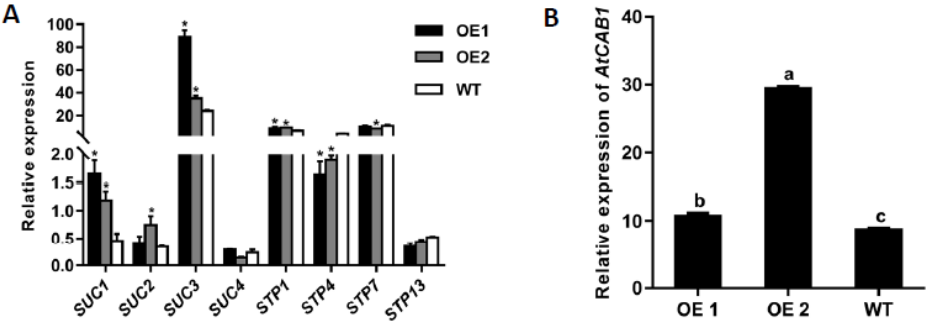
Figure 6. Effect of overexpressing CmTST1 on the plasma membrane-located sugar transporter expression. ( A ) qRT-PCR detected the expression of Arabidopsis sucrose transporter genes ( SUC1 , SUC2 , SUC3 , and SUC4 ) and sugar transporter genes ( STP1 , STP4 , STP7 , and STP13 ) in the roots of the CmTST1 OE Arabidopsis lines growing under the standard MS medium condition with 3% sucrose ( w / v ) as the only carbon source. ( B ) Comparison of relative expression of AtCAB1 in the OE lines and the WT. Error bars show the SE of the values from three replicates. * and lowercased letters on the bars indicate a significant difference between the WT and the transgenic lines ( p < 0.05; Student’s t - test).